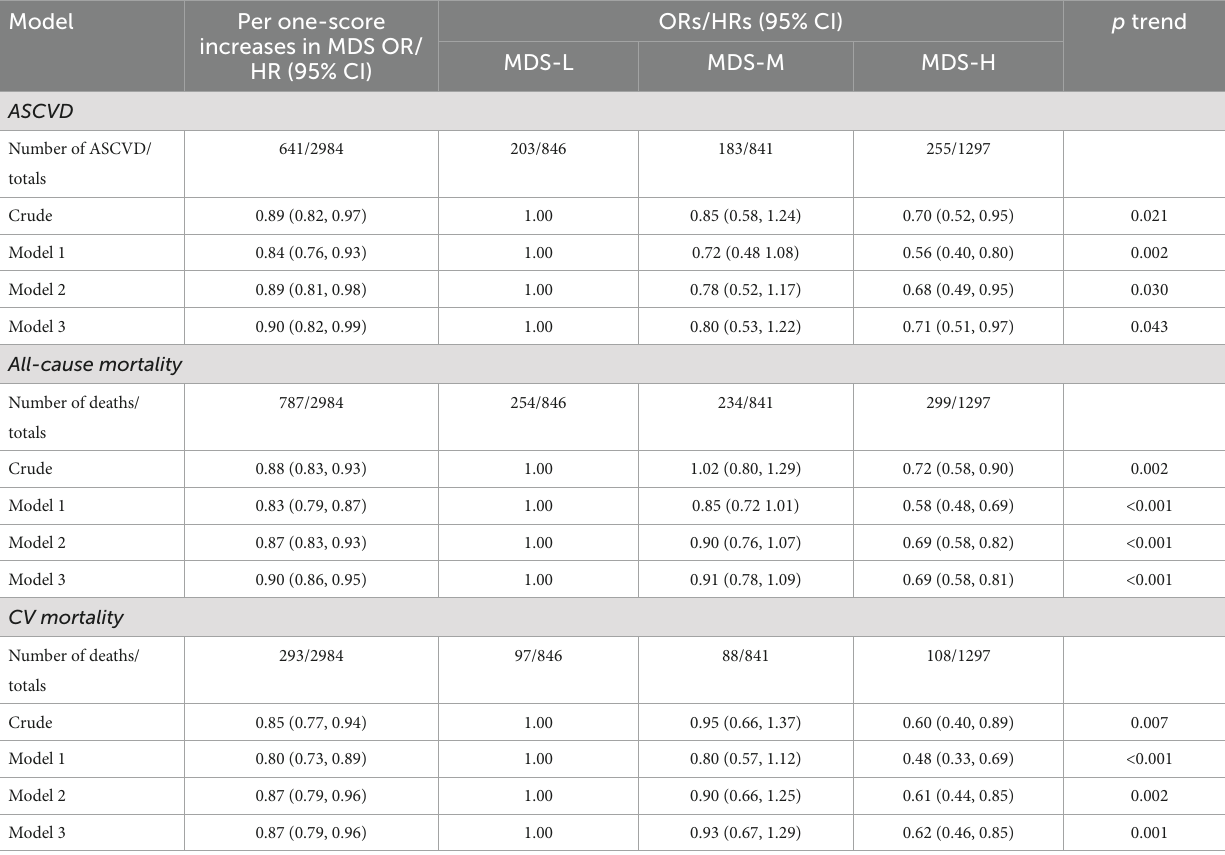
TABLE 3 Logistic regression analysis for the risk of ASCVD and Cox regression analysis for all-cause and cardiovascular mortality according to the MIND diet score among hypertensive patients.